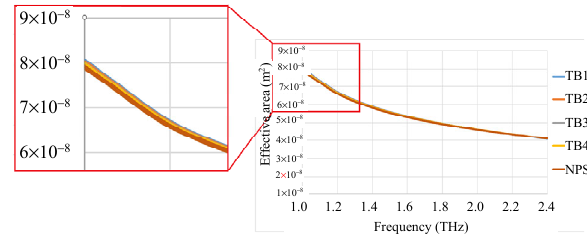
Fig. 8 A eff of the proposed sensor for various tuberculosis-infected samples versus frequency.